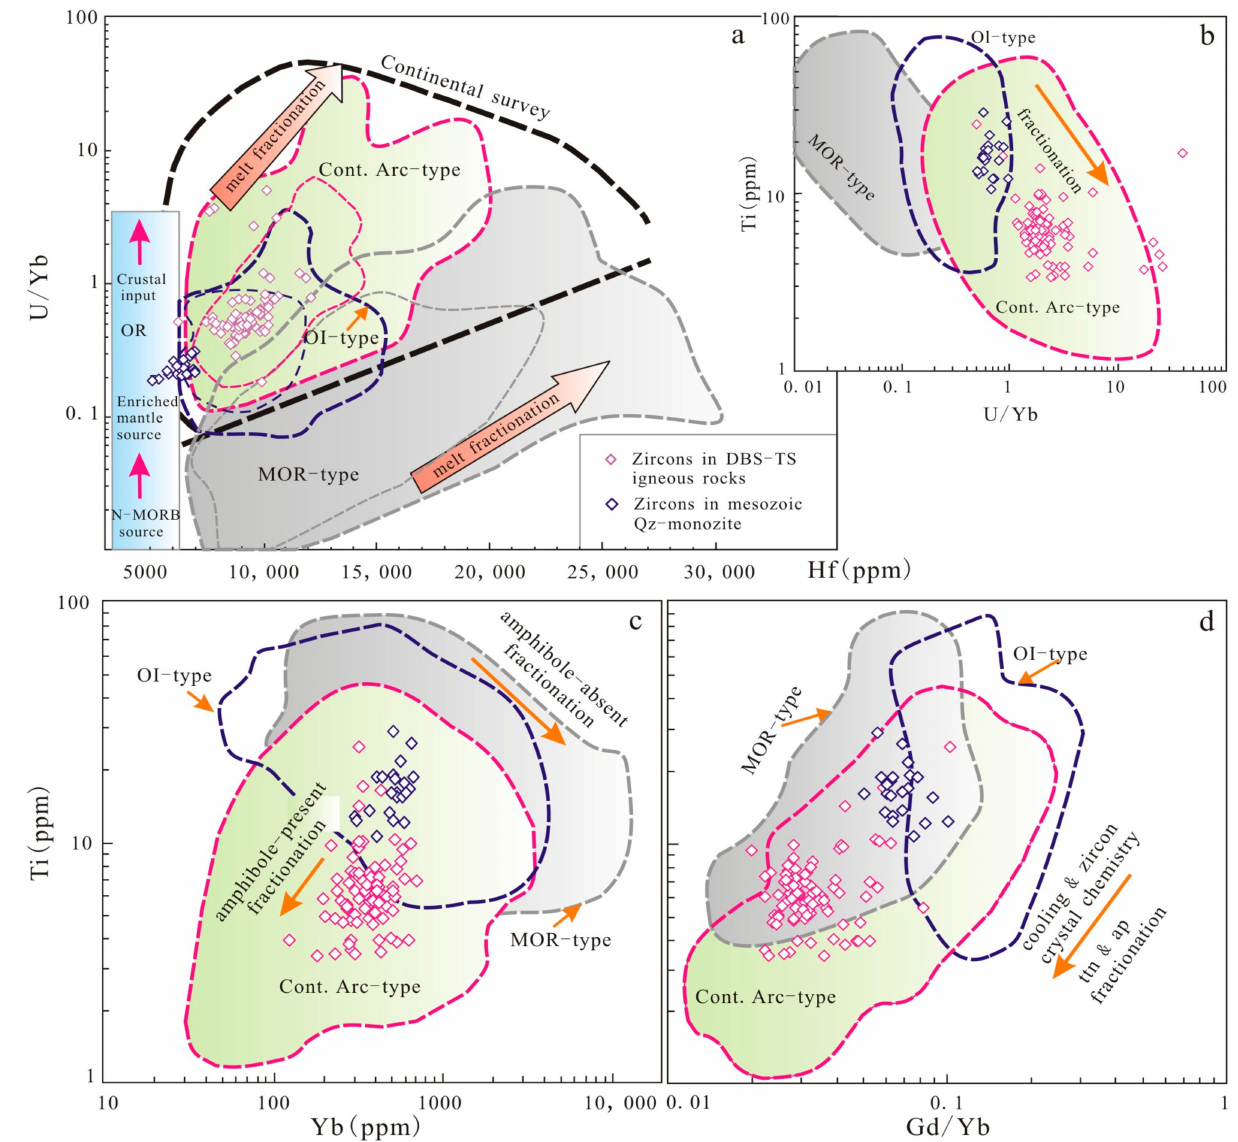
Figure 7. Discrimination diagrams based on trace elements of zircons ( a ) U/Yb versus Hf, ( b ) Ti versus U/Yb, ( c ) Ti versus Yb, and ( d ) Ti versus Gd/Yb in zircon (after [82]). The field-labeled “Continental Survey” and lower bound (bold line) in ( a ) were defined by Grimes et al. [83]. The colored symbols in ( b – d ) are the same as in ( a ). The green, grey and white fields circled by pink, grey and blue dashed lines are fields of Cont. Arc-type, mid-oceanic ridge (MOR)-type and ocean island (OI)-type, respectively, based on the compiled dataset of [82]. The thin dashed lines (pink, grey and blue) in ( a ) refer to the boundary of 80% density distribution. ( c ) highlights contrasting trends formed by the arrays for MOR and continental arc zircon. ( d ) Highlights similar covariation in both MOR and arc zircon driven by the influence of cooling and possibly co-crystallization of phases in competition for REE with later-formed zircon. Effects of fractional crystallization of amphibole on the composition of zircon are illustrated in ( c , d